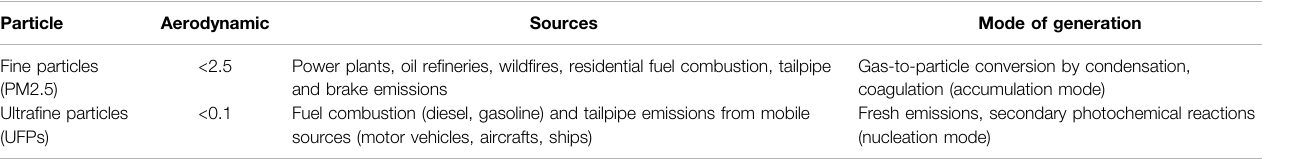
TABLE 2 | Classi fi cation of fi ne particles based on size *.